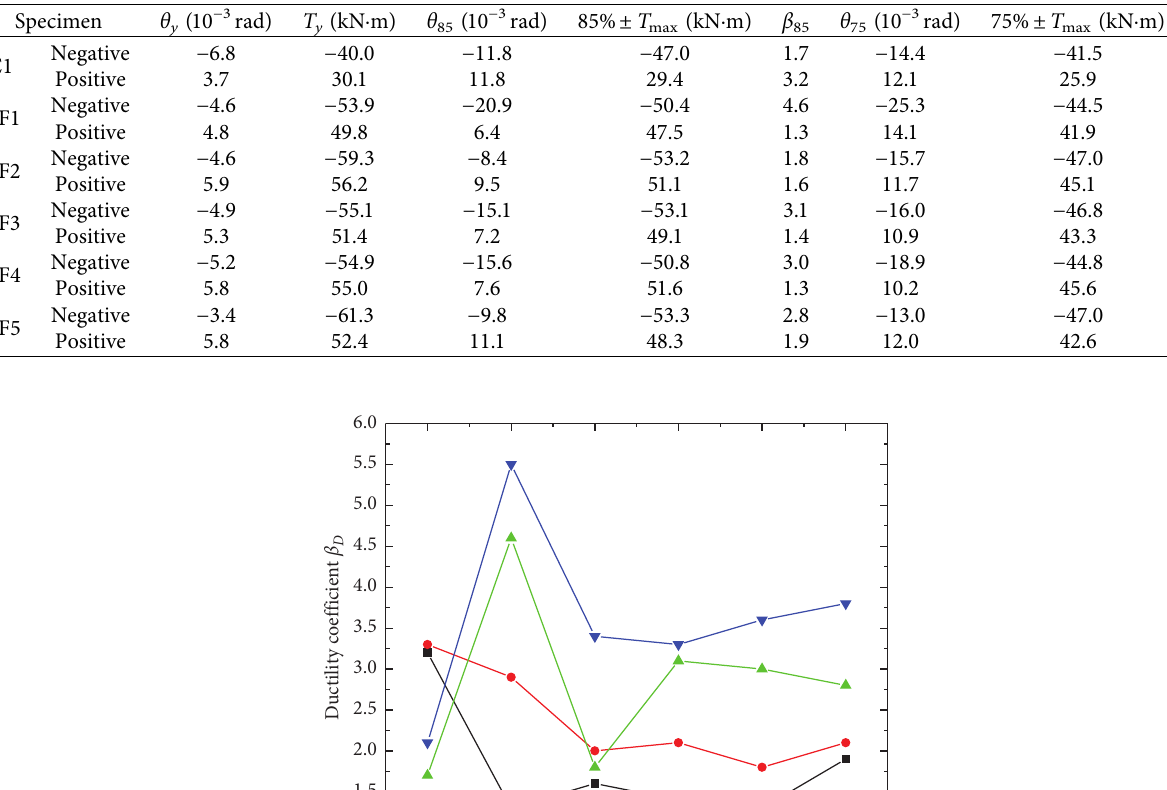
Figure 16: Envelop curves. (a) Envelop curves of six specimens. (b) Deterioration of C1 and SF1. Table 8: Ductility coefficient of specimens.